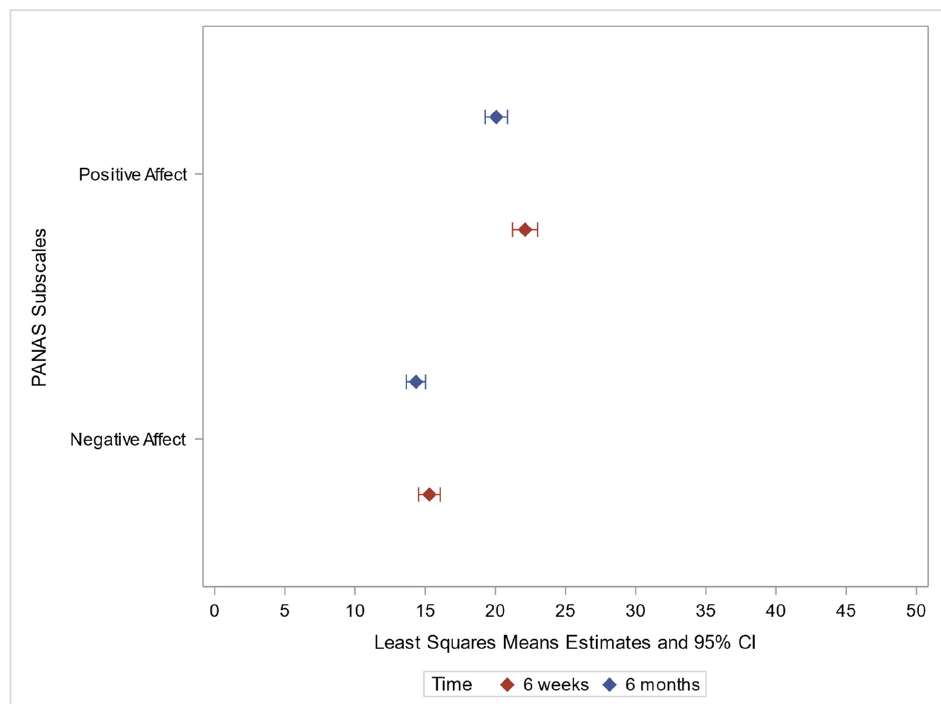
Figure 2. PANAS subscales Forest Plot.